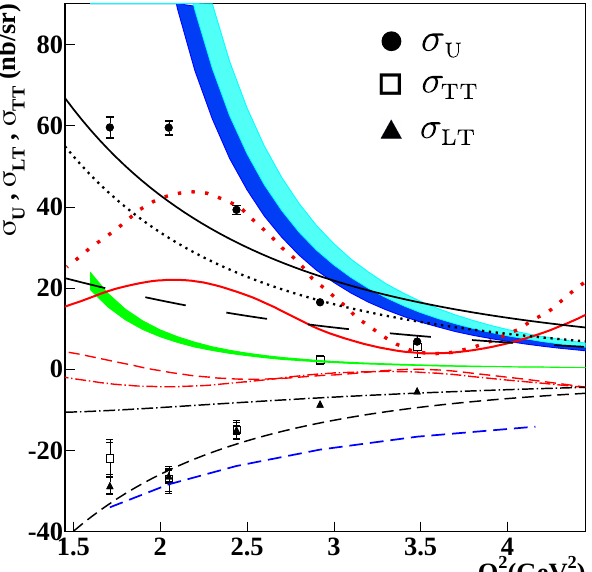
Figure 2. The structure functions, σ U = σ T + εσ L (solid dot), σ TT (square), and σ LT (triangle), as a function of Q 2 . ε describes the ratio between longitudinally and transversely polarized virtual photons, The inner error bars are statistical and the outer error bars are the combined systematic and statistical uncertainties in quadrature. The bands refer to model calculations of σ U in the TDA description, green band: Braun-Lenz-Wittmann next-to-next-to-leading-order (BLW NNLO), dark blue band: Chernyak-Ogloblin-Zhitnitsky (COZ), and light blue band: King-Sachrajda (KS) (see [16] and Refs. therein for the meaning of these models). The lower blue short-dashed line represents an educated guess to fit the higher twist cross-sections σ LT and σ TT in the TDA picture. The red curves are the “Regge” predictions (by JML18) of [19,20] for solid: σ U , dashed curve: σ LT , dot-dashed: σ TT . An updated σ U calculation from JML18 model [21] are shown in the red dotted curve. Regge calculations which consider parton contributions (see Ref. [11]) to σ U , σ T , σ L , σ TT and σ LT are shown in black solid, black dotted, black long-dashed, black dot-dashed, and black short-dashed, respectively. This plot was recreated from the data and model predictions published in Refs.